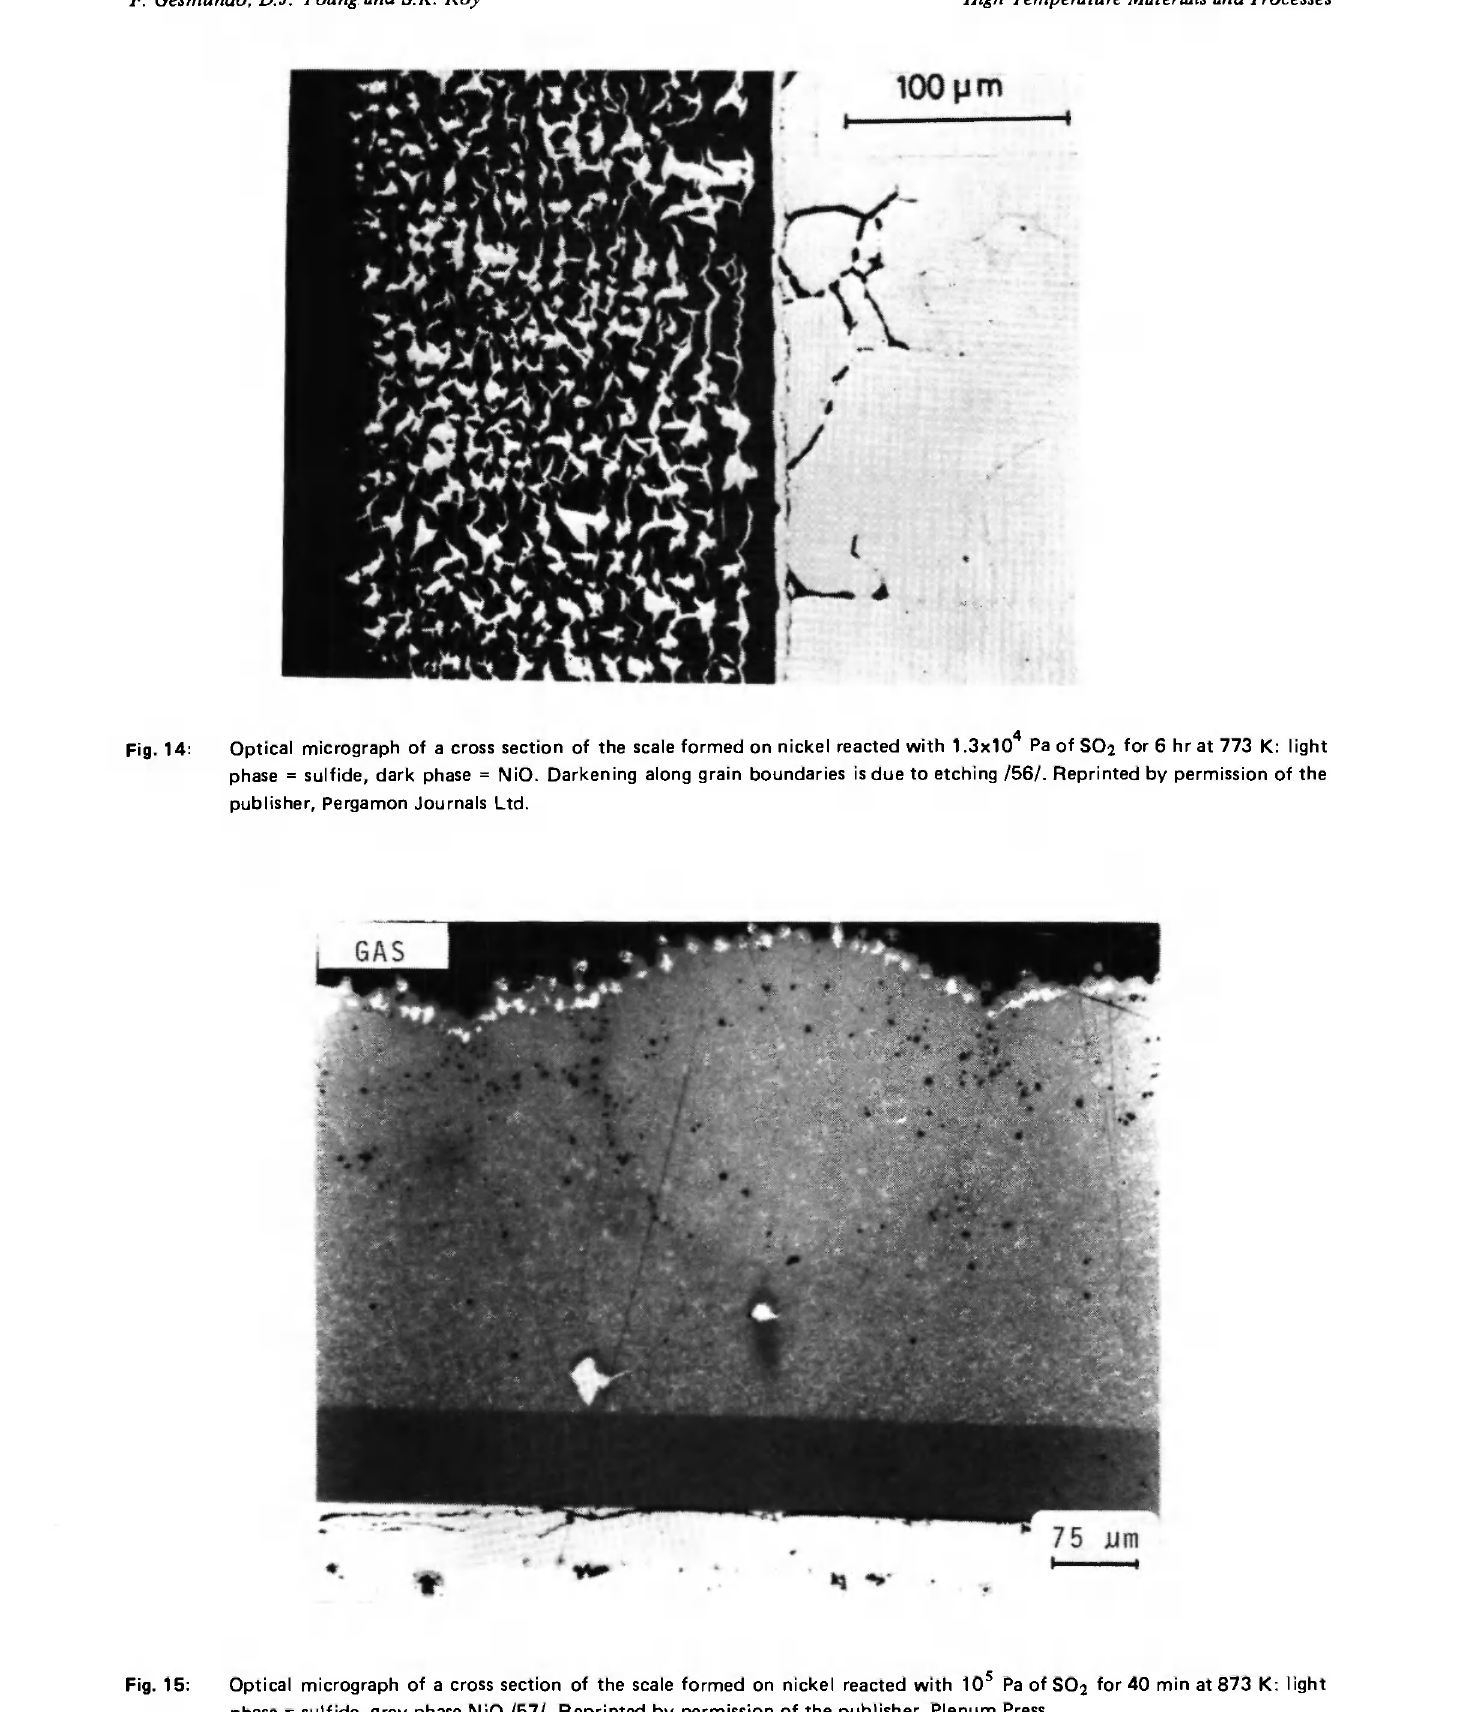
Fig. 14: Optical micrograph of a cross section of the scale formed on nickel reacted with 1.3x10 Pa of SO2 for 6 hr at 773 K: light phase = sulfide, dark phase = NiO. Darkening along grain boundaries is due to etching 1561. Reprinted by permission of the publisher, Pergamon Journals Ltd.